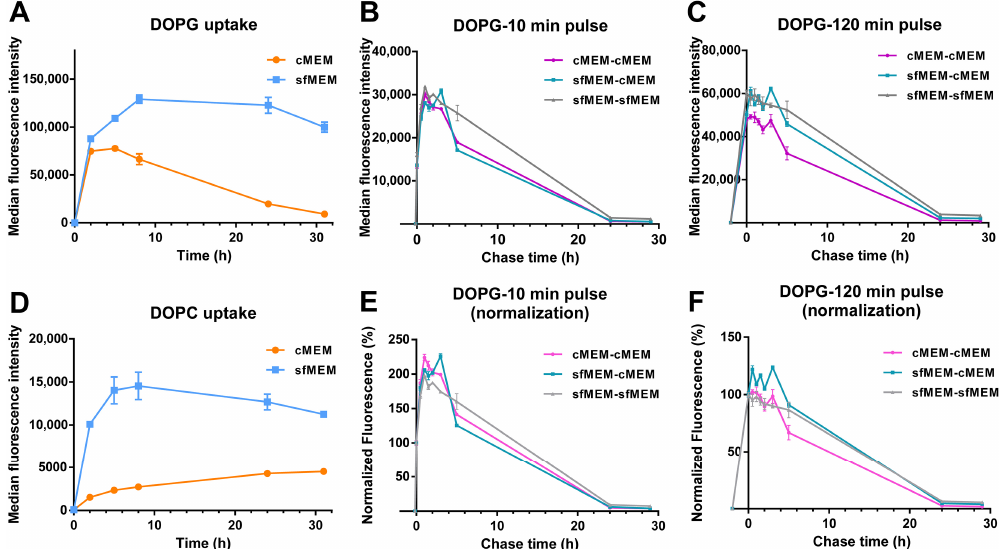
Figure 6. Comparison of liposome uptake and release in cMEM and sfMEM. ( A and D ) Uptake kinetics of DOPG liposome ( A ) and DOPC liposome ( B ) in cMEM and sfMEM. HeLa cells were exposed to 62 µg/ml DOPG or DOPC liposomes dispersed in cMEM or sfMEM and collected after different exposure times for flow cytometry measurement as described in Methods. The results are the average and standard deviation over 2 replicates of the median cell fluorescence intensity obtained by flow cytometry. ( B , C , E and F ) Release kinetics of HeLa cells after exposure to DOPG liposomes dispersed in different media. HeLa cells were exposed to 62 µg/ml DOPG liposomes in cMEM or sfMEM for ( B and E ) 10 min or ( C and F ) 120 min (pulse), followed by removal of the extracellular liposome dispersion and further incubation (chase) in cMEM or sfMEM without lipo- somes. The length of the pulse in each experiment is indicated on the x axis as a negative time point (prior to the start of the chase). Cells were then collected at different chase times for flow cytometry analysis as described in Methods. The results are the average and standard deviation over 2 repli- cates of the median cell fluorescence intensity obtained by flow cytometry. In ( E ) and ( F ), the same data are shown after normalization for the fluorescence at 0 h chase.